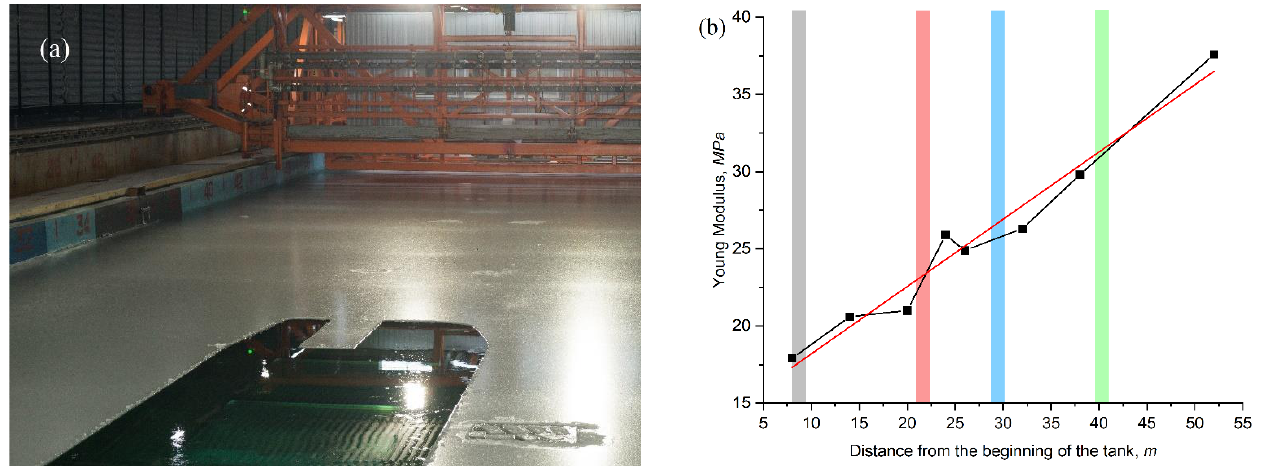
Figure 2. ( a ) The overview of an ice model’s cantilever beam prepared for an experiment and ( b ) variations in the elastic modulus of the ice model throughout the length of Floe 1: black points — measurements, red line — fitted linear tendency, colored rectangles — positions of cantilever beams.